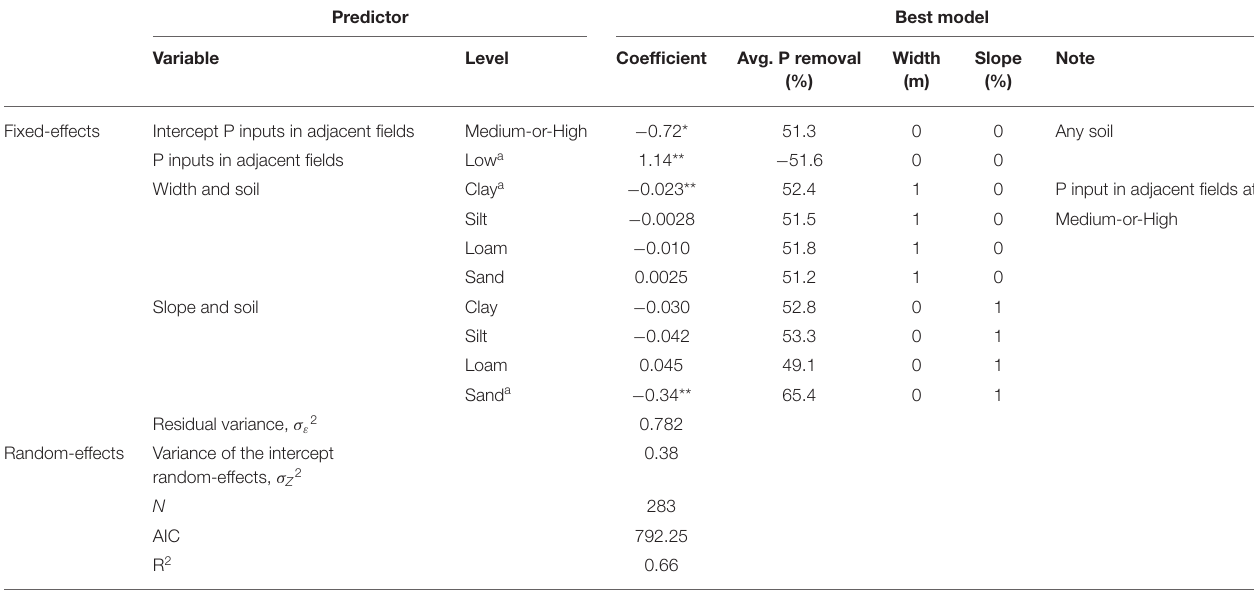
TABLE 4 | The best regression model. Predictor Best model Variable Level Coefficient Slope